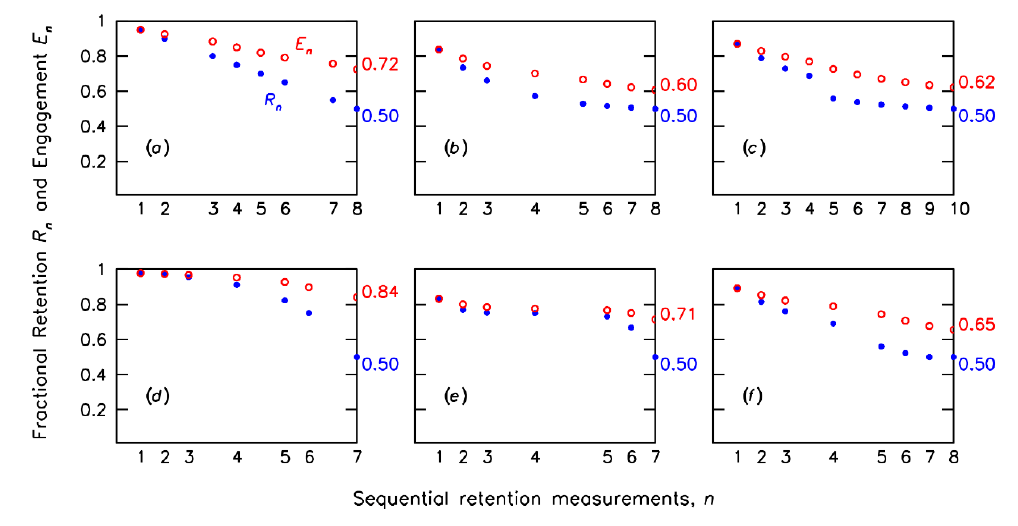
Discrete Time Sampling Cases for the Same Retention and Engagement Examples Shown in Figure 2.